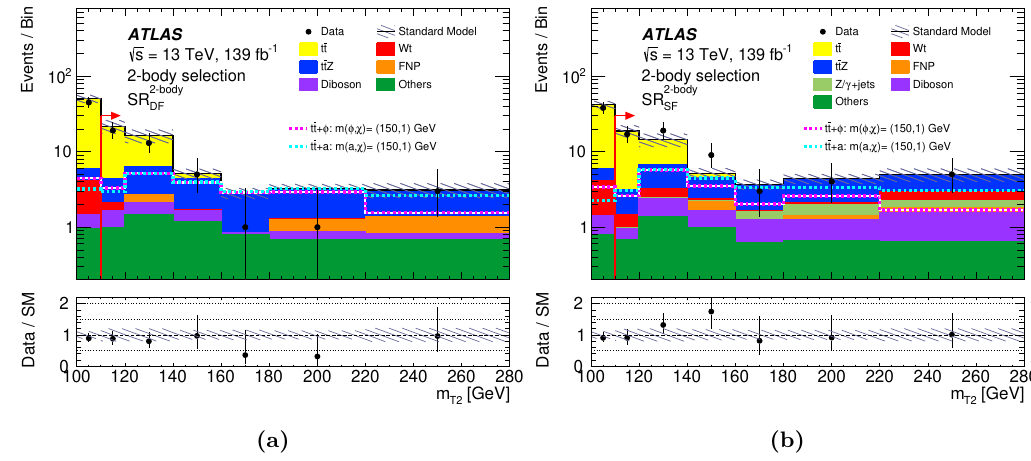
Figure 11 . Two-body selection. Distributions of m ‘‘ in SR 2-body for (a) different-flavour and 110 , ∞ T2 (b) same-flavour events satisfying the selection criteria of the given SR, except the one for the presented variable, after the background fit. The contributions from all SM backgrounds are shown as a histogram stack. “Others” includes contributions from V V V , tt t , tttt , tt W , tt WW , tt WZ , tt H , and tZ processes. The hatched bands represent the total statistical and systematic uncertainty. The rightmost bin of each plot includes overflow events. Reference dark-matter signal models are overlayed for comparison. Red arrows in the upper panels indicate the signal region selection criteria. The bottom panels show the ratio of the observed data to the total SM background prediction, with hatched bands representing the total uncertainty in the background